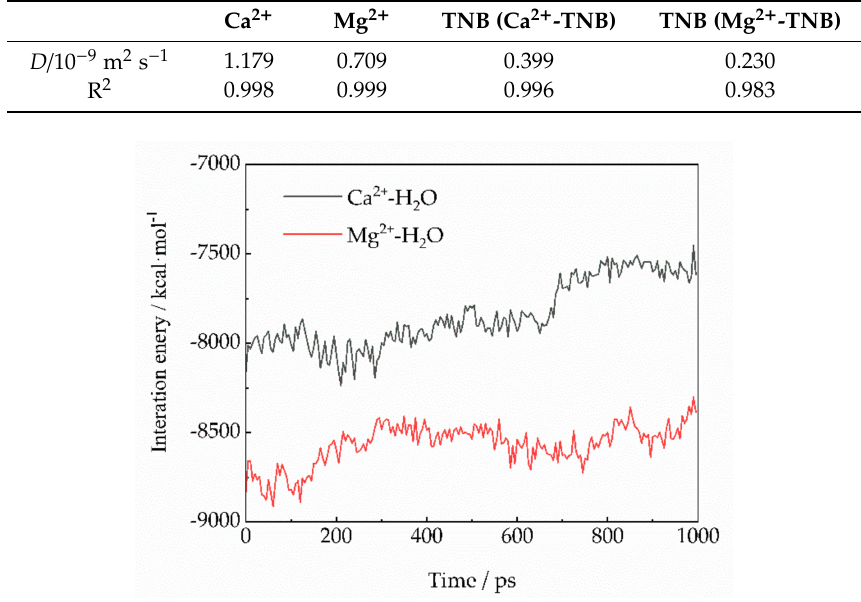
Figure 3. Mean square displacement (MSD) of TNB and ions in di ff erent systems. Table 2. Di ff usion coe ffi cients of TNB and ions in di ff erent systems.